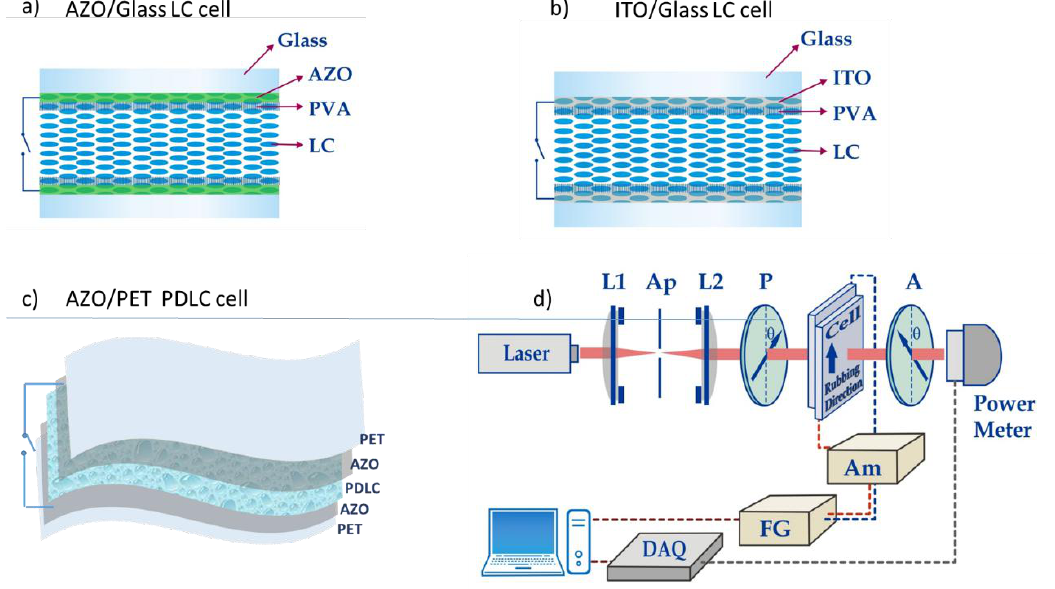
Figure 5. Schematic diagrams of: ( a ) AZO / glass LC cell; ( b ) ITO / glass LC cell and ( c ) AZO / PET polymer-dispersed liquid crystal (PDLC) cell and ( d ) experimental setup to measure the electro-optical modulation behavior. Legend: lens (L), aperture (Ap), polarizer (P), analyzer (A), amplifier (Am), function generator (FG), data acquisition card (DAQ). Note: for PDLC cell measurements, the P and A are removed from the setup.